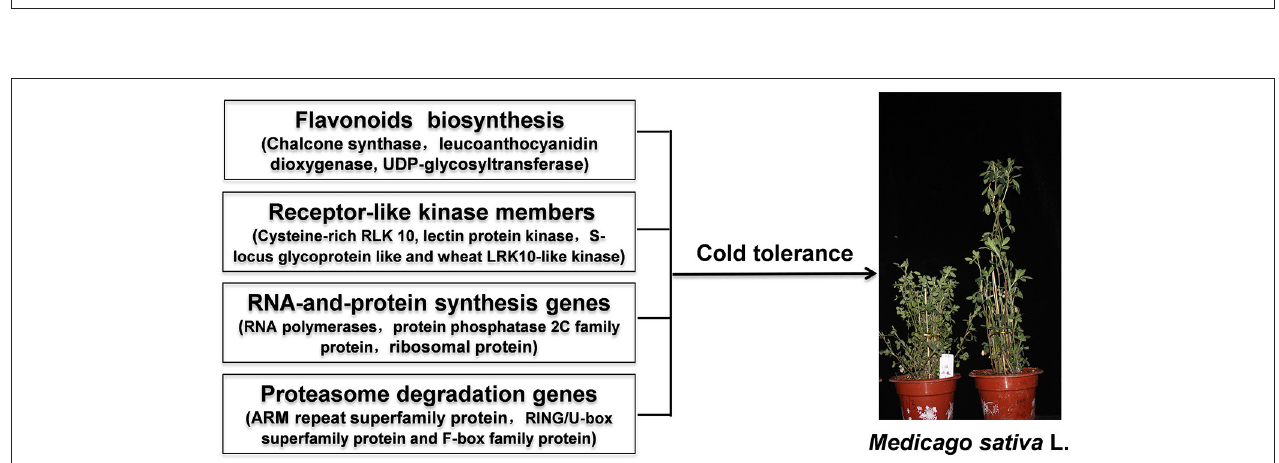
FIGURE 8 | Comparison between the results of the RT-qPCR and RNA-Seq analyses of selected DEGs. The color scale indicates log 2 -transformed fold changes of gene expression levels. Red, blue, and gray denote upregulation, downregulation, and no change in expression, respectively.